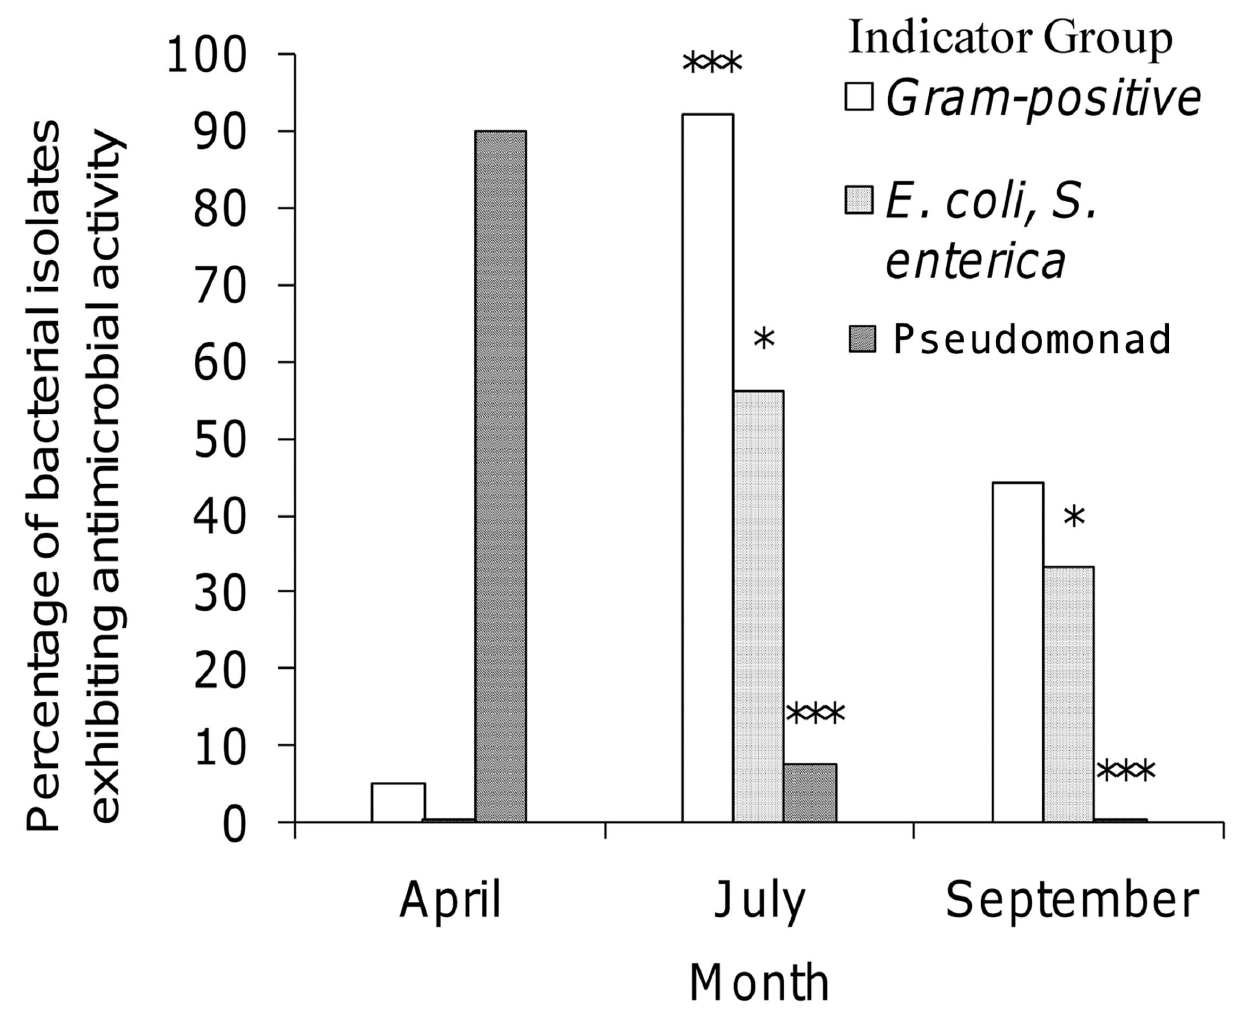
FIGURE1 Seasonal variation of selected isolates procured from honey stomachs. Open bar = percentage of bacterial isolates being Gram-positive; dotted bar = percentage of bacterial isolates being antagonistic against E. coli or S. enterica ; striped bar = percentage of bacterial isolates being Pseudomonad sp. *** p < 0.001 when compared to April (A). * p < 0.05 when compared to April